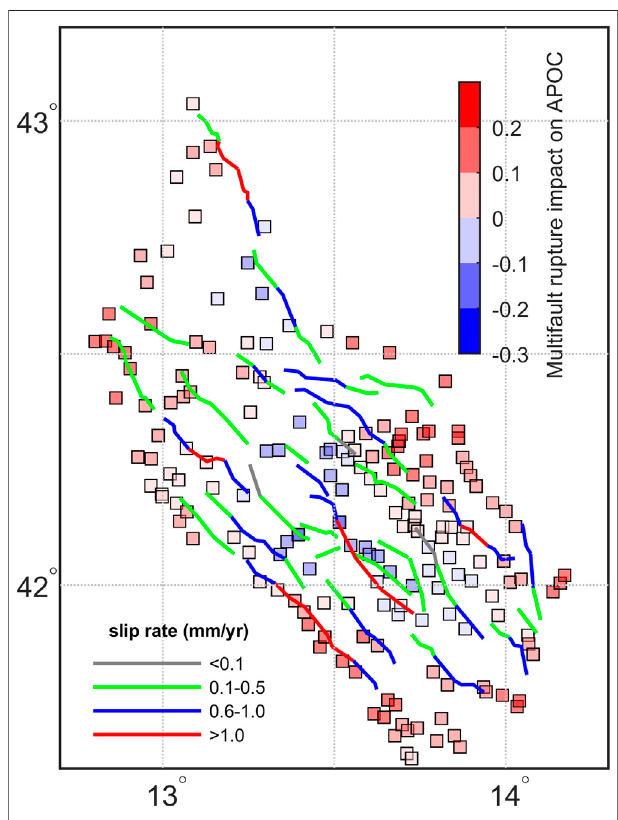
FIGURE 10 | Difference in the annual probability of collapse (APOC) at thelocalities( fi lledsquares)betweenconsideringinthelistofrupturescenarios the possibility of complex multi-fault ruptures (CMFR APOC ) or only ruptures con fi ned within the main faults (OMFR APOC ): (CMFR APOC - OMFR APOC )/ OMFR APOC . Red implies higher values for the CMFR